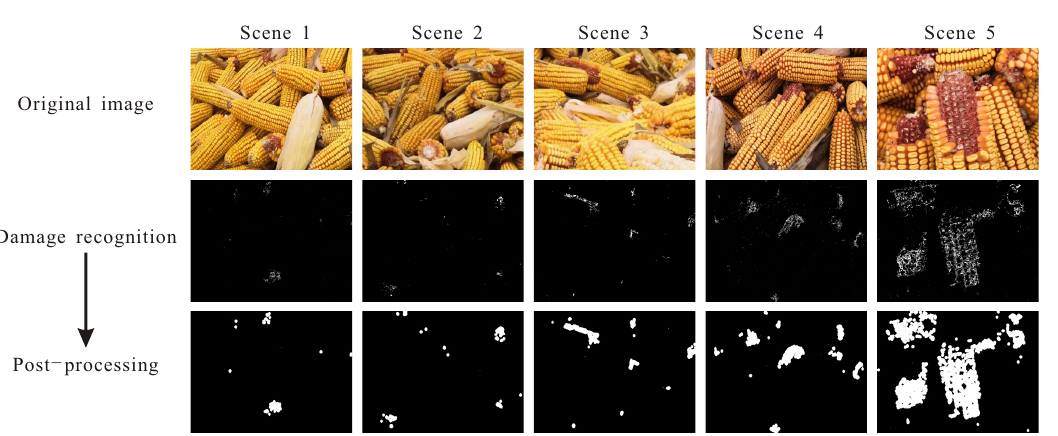
Figure 12. Results on kernel recognition of multiple ears.